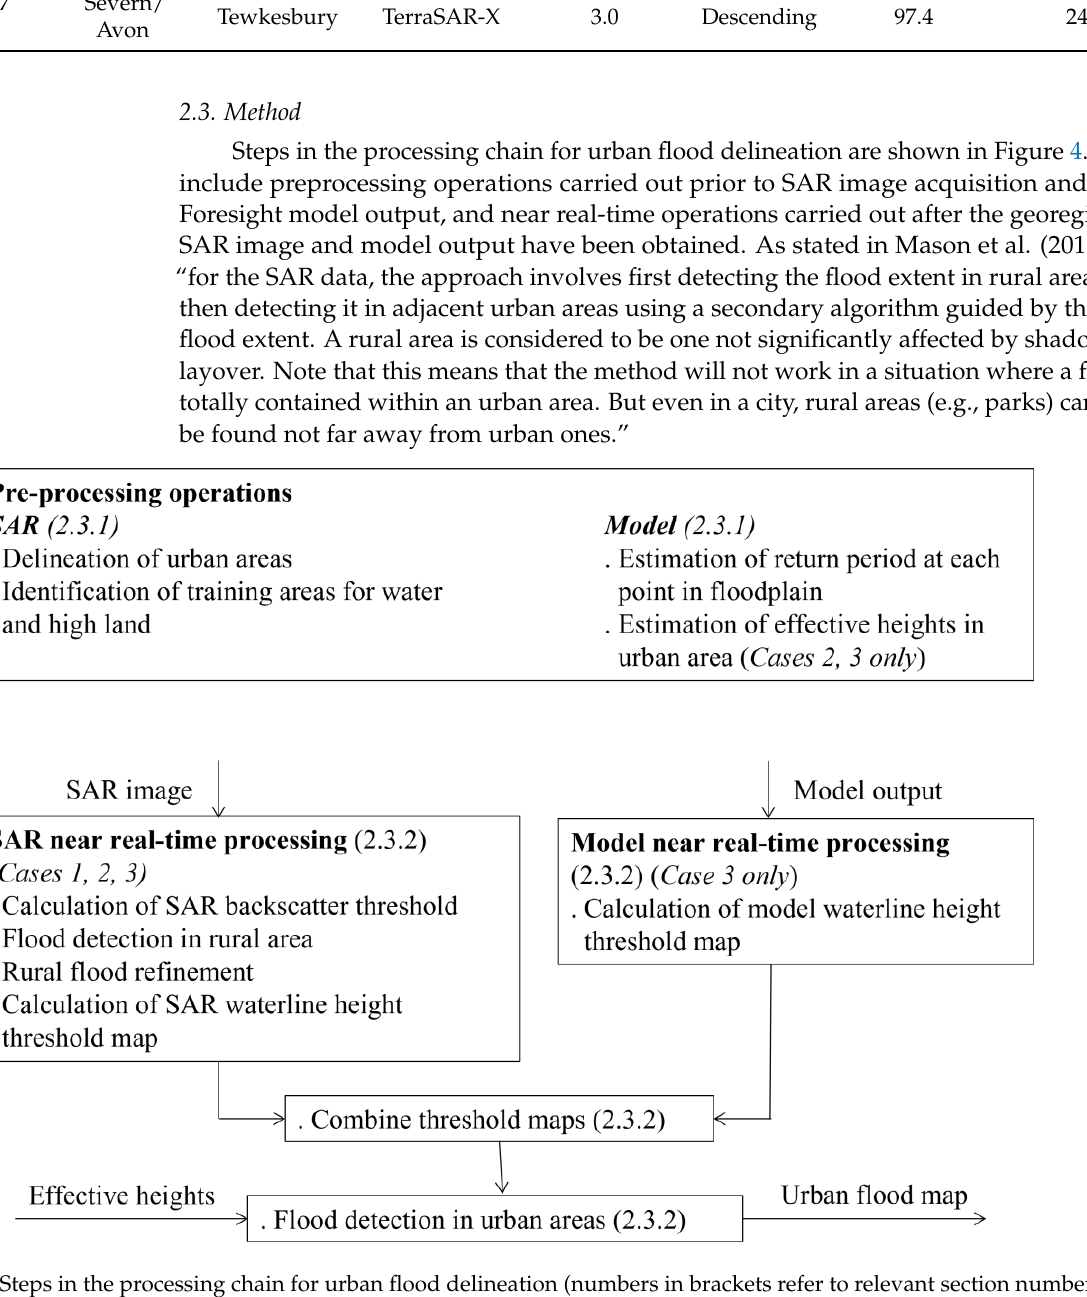
Figure 4. Steps in the processing chain for urban flood delineation (numbers in brackets refer to relevant section numbers; case numbers in italics; brackets refer to cases considered in the Results section) .